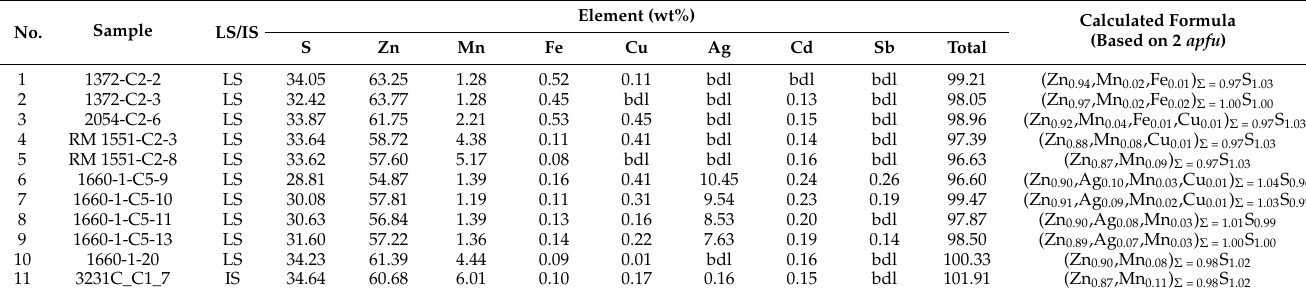
Below detection limit values were obtained for Au, As, Pb, Se, Sn, and Te in all measured points; “bdl” = below detection